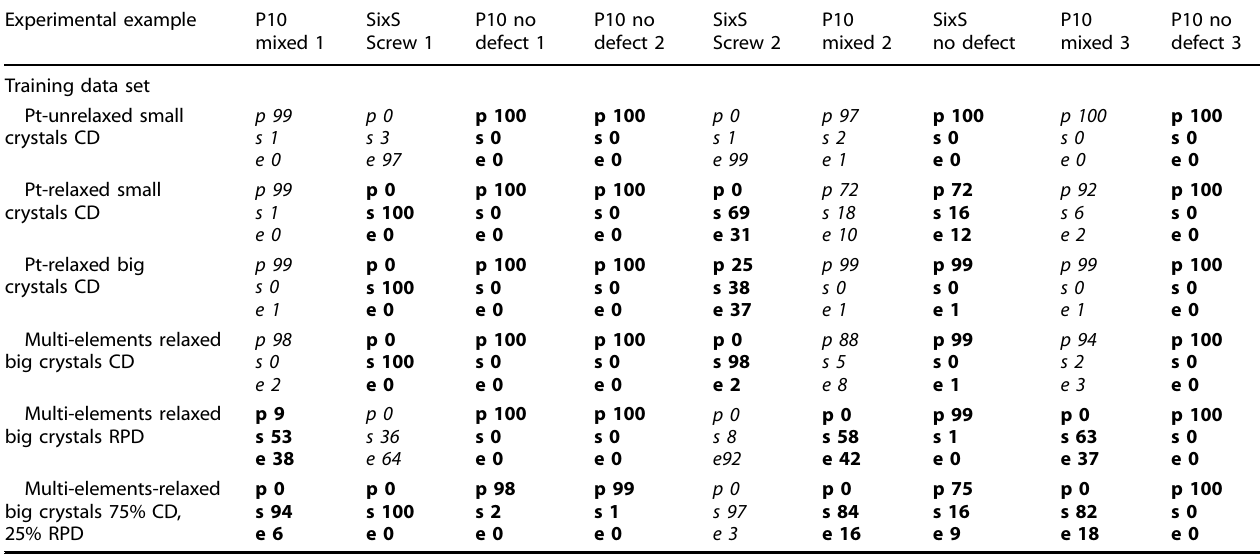
Table 1. Predicted probabilities in % on the experimental data from several models trained with different simulated training data sets. Experimental